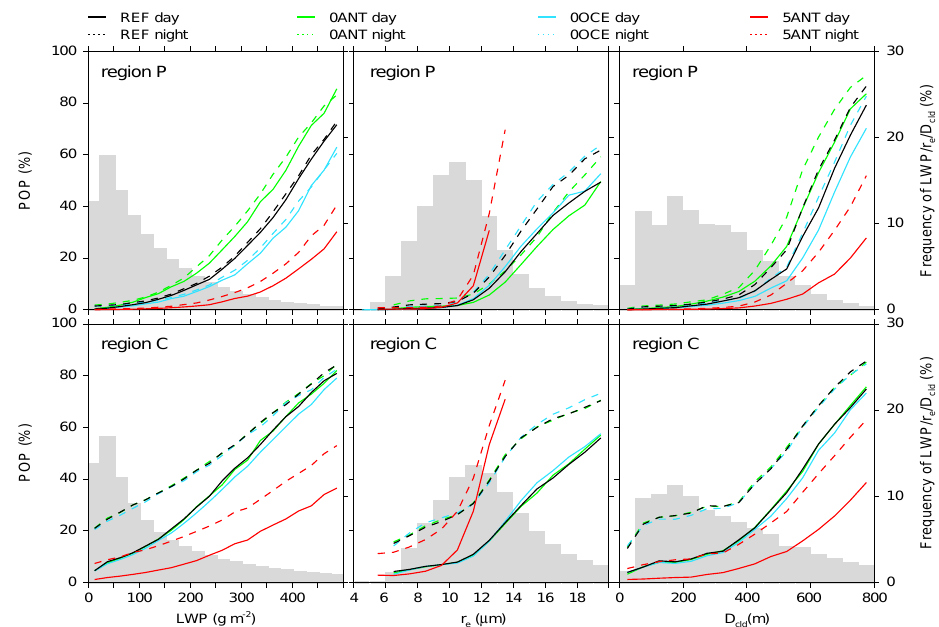
Fig. 6. Relationships between the probability of precipitation (POP) and liquid water path (LWP, left), cloud top effective radius ( r e , middle) and cloud thickness ( D , right) during the day (solid lines) and the night (dashed lines) in the reference simulation (REF, black) and in the 3 sensitivity simulations with regional anthropogenic emissions turned off (0ANT, green), with regional oceanic emissions turned off (0OCE, blue), and with scaled regional anthropogenic emissions (5ANT, red), respectively, for two regions with low (region P) and high (region C) aerosol-cloud interactions. The histograms of LWP (left), r e (middle), and D (right) in the REF simulation are shown as the grey shaded areas. The figure is calculated based on hourly outputs on each model